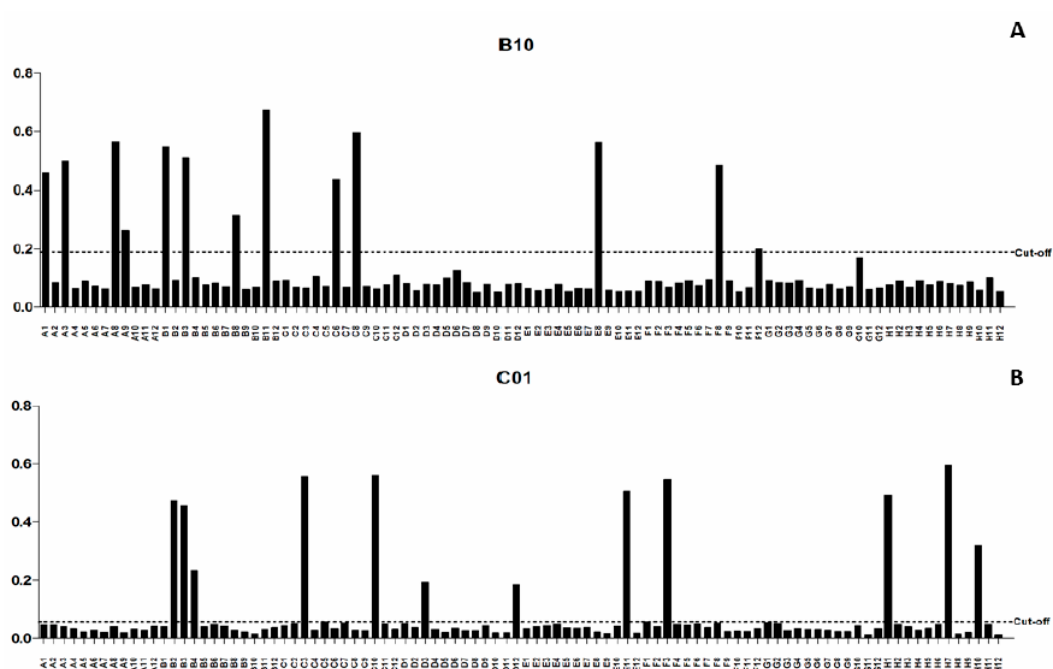
Figure 1. Evaluation of the soluble scFv expression after IPTG induction in the selected clones. The presence of soluble scFv fragments was evaluated after induction by IPTG using an anti-HA antibody and ELISA method. The scFv clones secreted anti-B10 phages were in a total of 13 ( A ) and anti-C01 in a total of 12 ( B ). In the x-axis we have the 96 possible clones secreted, in the y-axis we have the absorbance at 492 nm of the induced solution; the cut-offs were calculated based on the mean of the negative controls (clones that were not expressed) more or less two times the (SD) standard deviation (A and B).